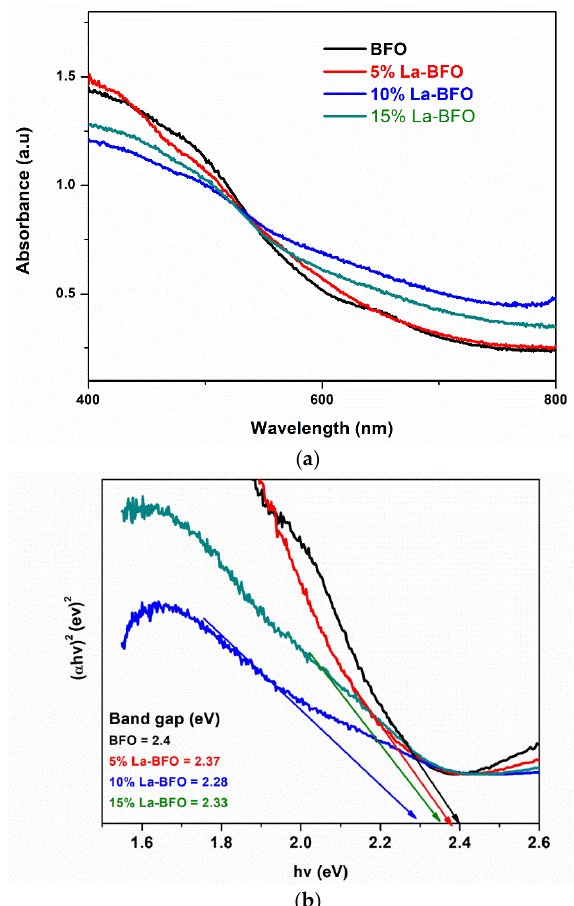
Figure 2. ( a ) UV-Vis diffuse reflectance spectra and ( b ) the band gap edges of BFO, 5% La-BFO, 10% La-BFO and 15% La-